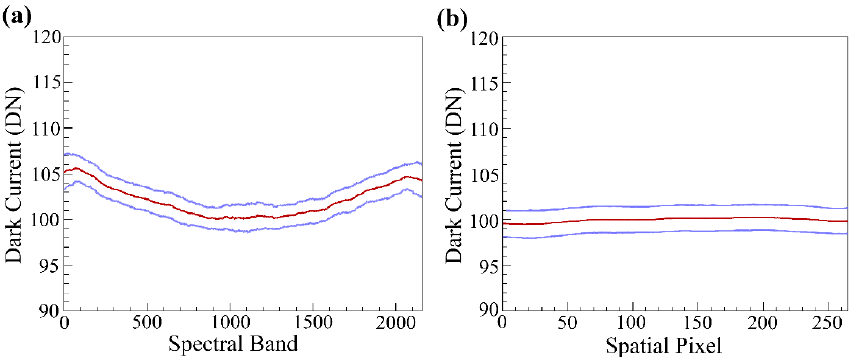
Figure 8. ( a ) Mean dark current (red line) as measured with GLAMR observations. Additionally, shows ±1 standard deviation (blue lines) across FIREFLY spectral bands; ( b ) mean dark current (red line) as measured with GLAMR observations. Additionally, shows ± 1 standard deviation (blue lines) across FIREFLY spatial pixels.